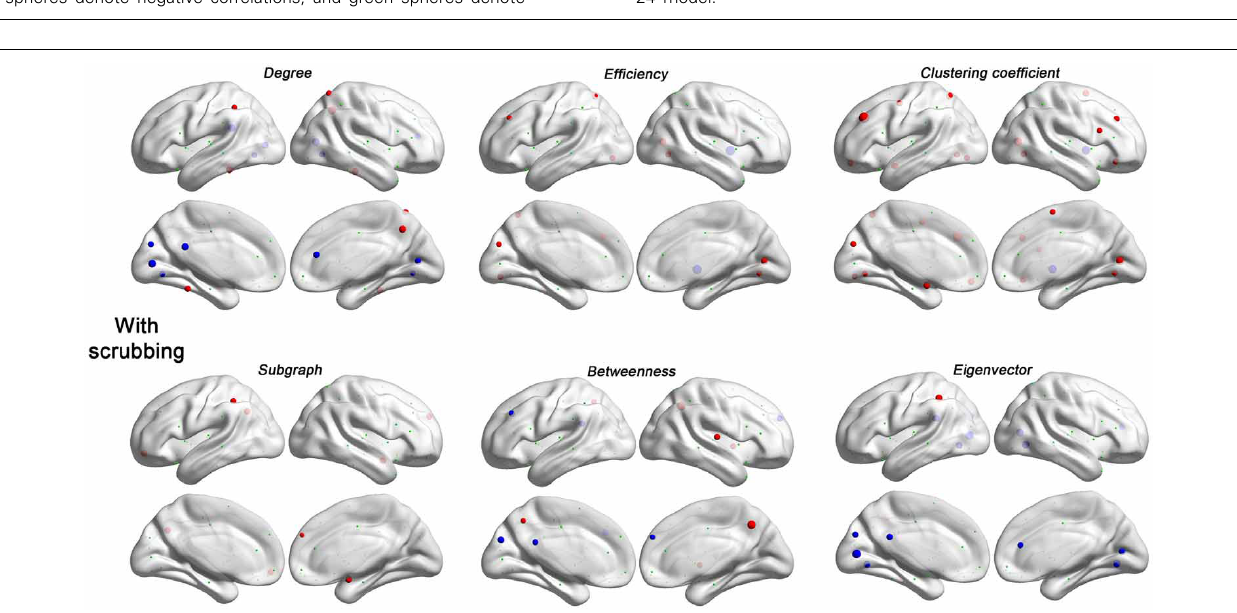
correlation with these AUCs was demonstrated. The size of spheres denotes the strength of correlation, red spheres denote positive correlations, blue spheres denote negative correlations, and green spheres denote insignificant correlations ( p > 0 . 05, | r | <